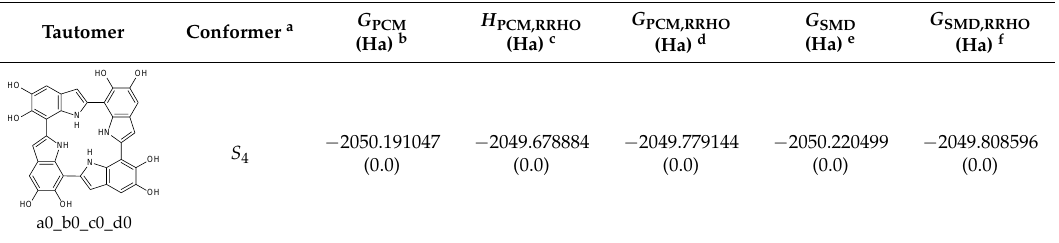
Table 2. KP-Red, neutral form in water.